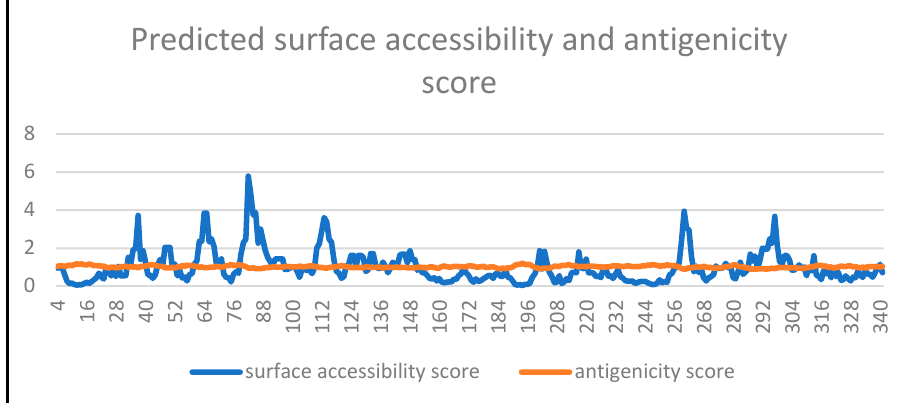
Figure 6. Prediction score for surface accessibility and antigenicity of the fungal protein.